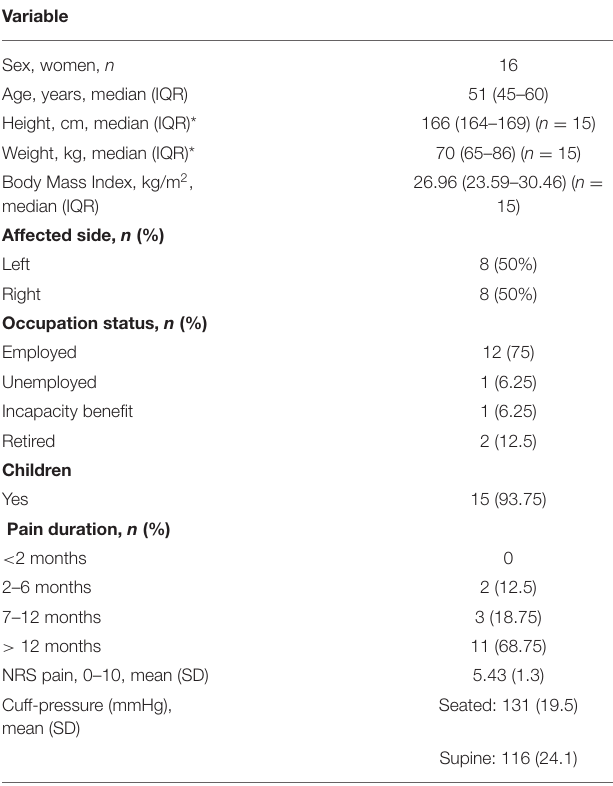
TABLE 1 | Baseline characteristics ( n =